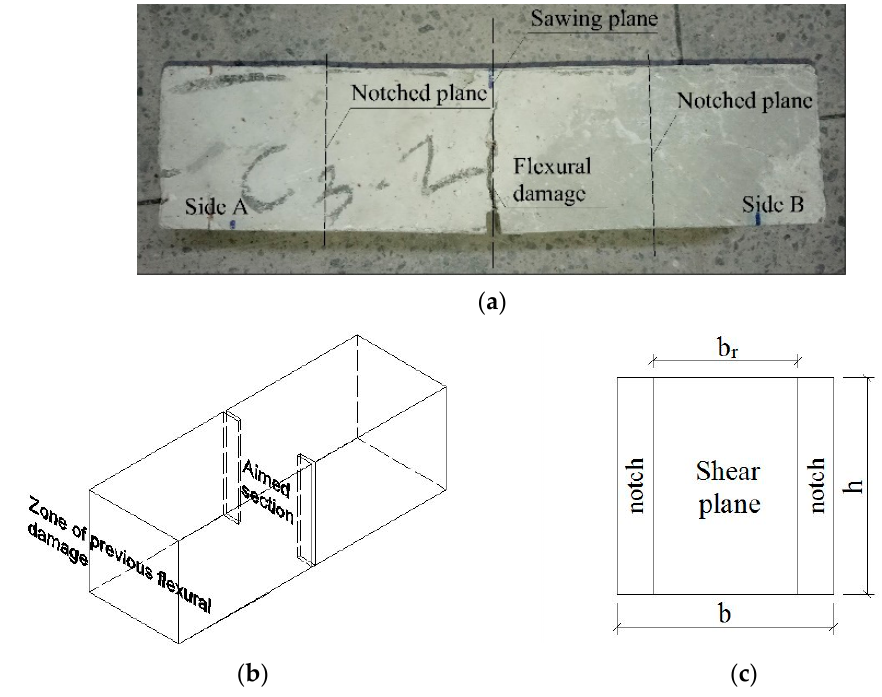
Figure 4. Preparation of the prisms for the FIP shear test: ( a ) sawing plane and notching of a prism after the flexural test; ( b ) double-notched prism for the shear test; ( c ) cross-section of the sliding plane. Table 2. Details of prismatic